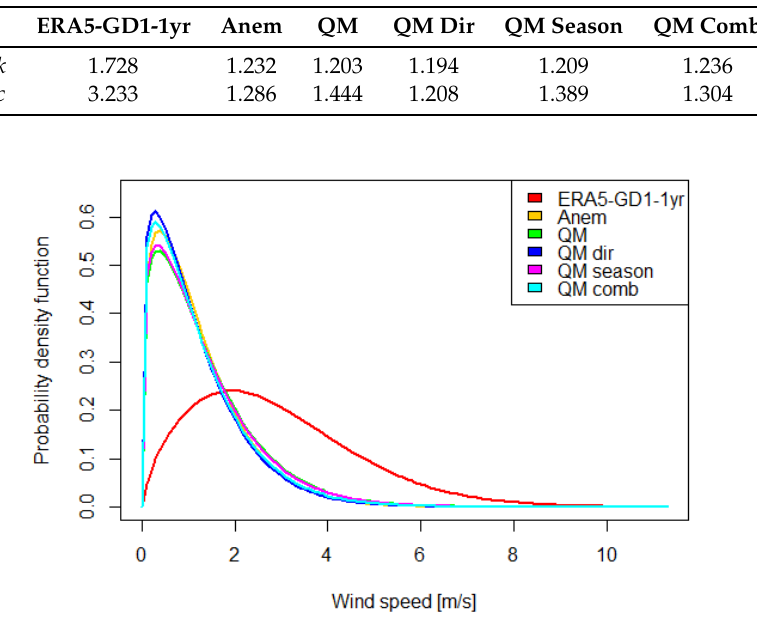
Table 7. Coefficients of the Weibull distributions of various wind speed time series covering a 1-year period, using only certain wind directions.